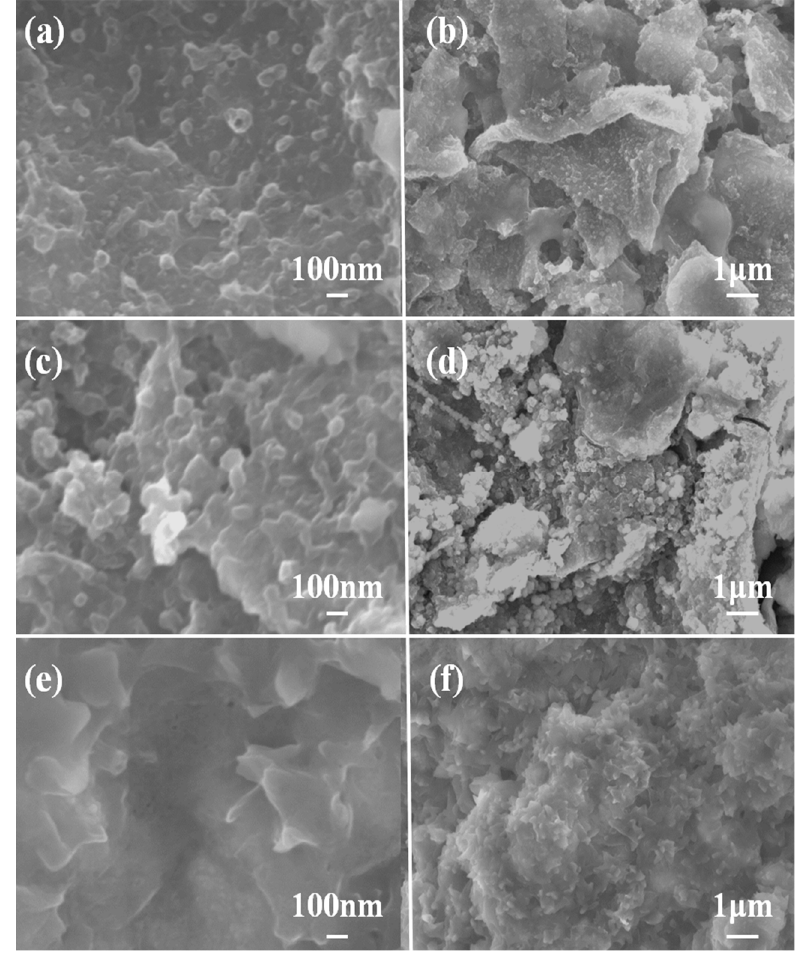
Figure 7. SEM images of ( a , b ) SnS/NG, ( c , d ) SnS/G, and ( e , f ) SnS after 100 cycles.